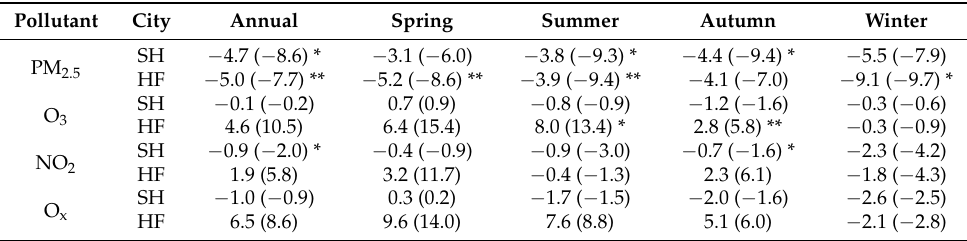
Table 1. Annual and seasonal linear trends of air pollutant concentrations from 2015–2019 (unit: µ g/m 3 /yr) in Shanghai (SH) and Hefei